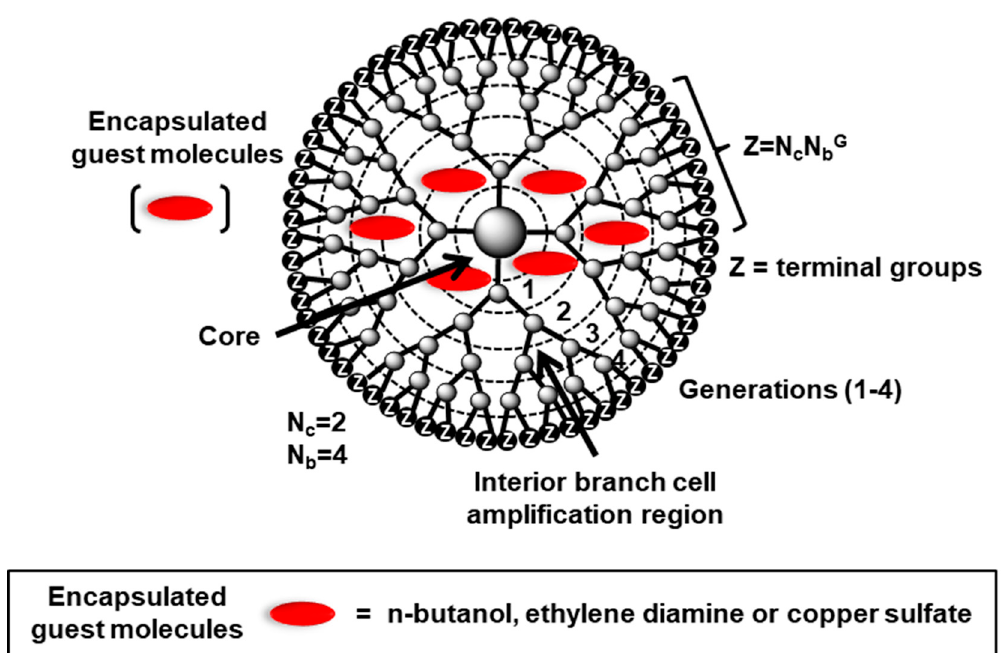
Figure 10. Unimolecular encapsulation of guest molecules (red ellipsoids) in a PAMAM dendrimer host. Where, first observed guest molecule examples = n-butanol, copper sulfate [10]; aspirin, 2,4-dichloro-phenoxy acetic acid [20].